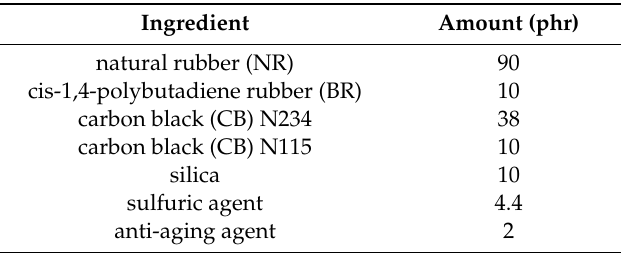
Table 1. Amounts of ingredients in the